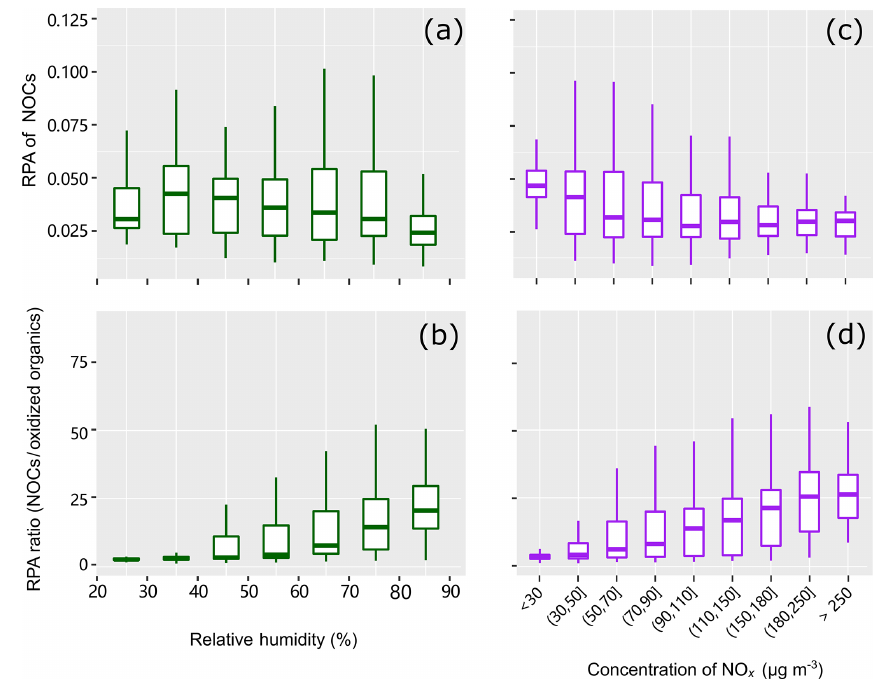
Figure 6. The dependence of NOCs and the ratio of NOCs to the oxidized organics on RH and NO x